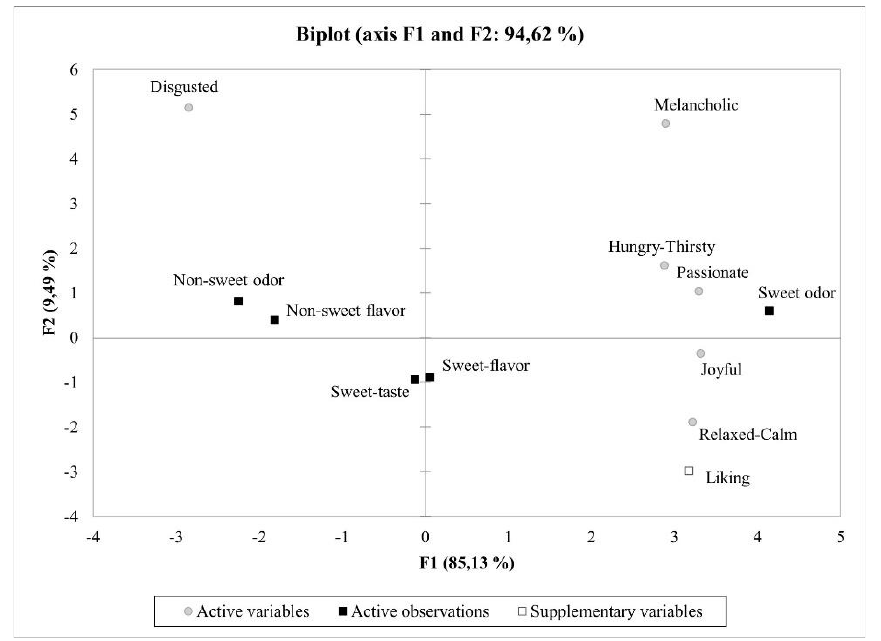
Figure 6. PC1 and PC2 biplot of the PCA (principal component analysis) showing the relationship among emotions elicited by the different samples (liking as supplementary variable).